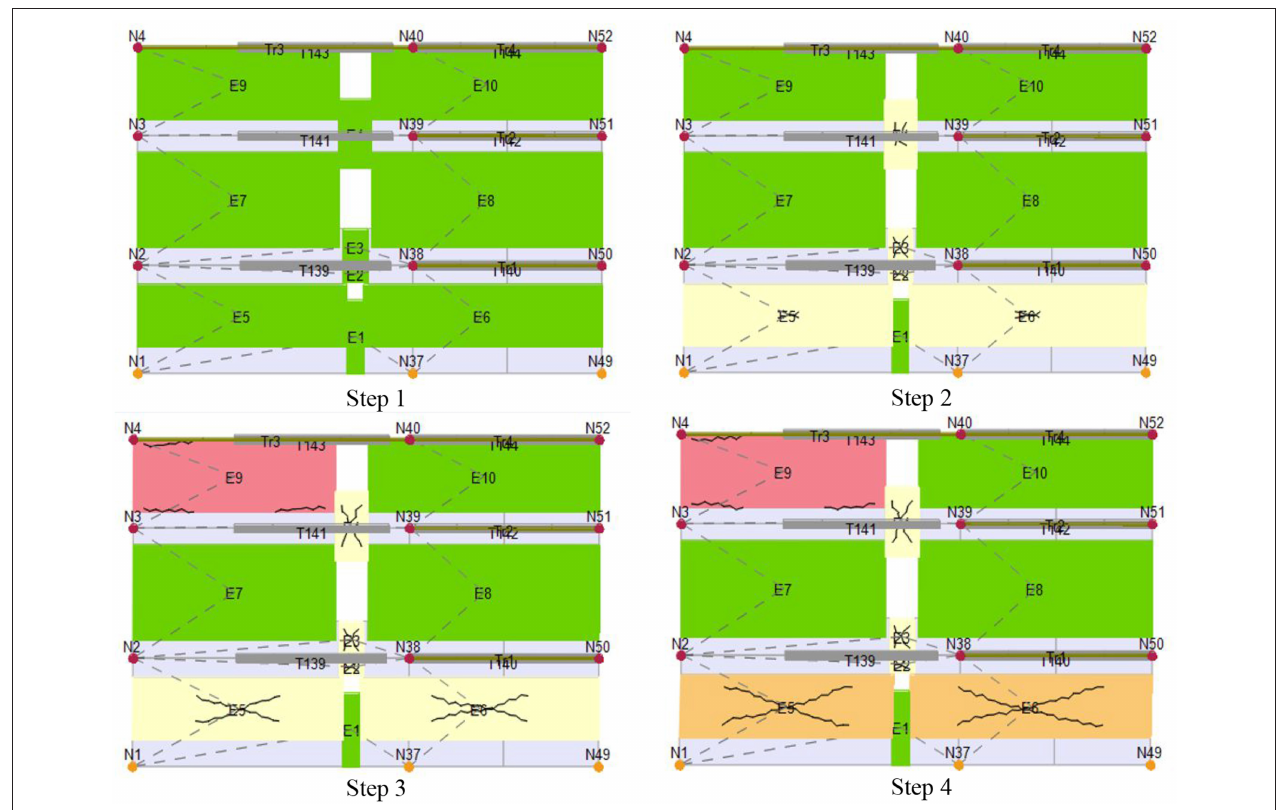
FIGURE 4 | Progressive damaging state of piers and spandrels of the P1 wall in the analysis n. 15 (green: no damage, pink: compression-bending moment plastic, light yellow: shear plastic, orange: shear failure).